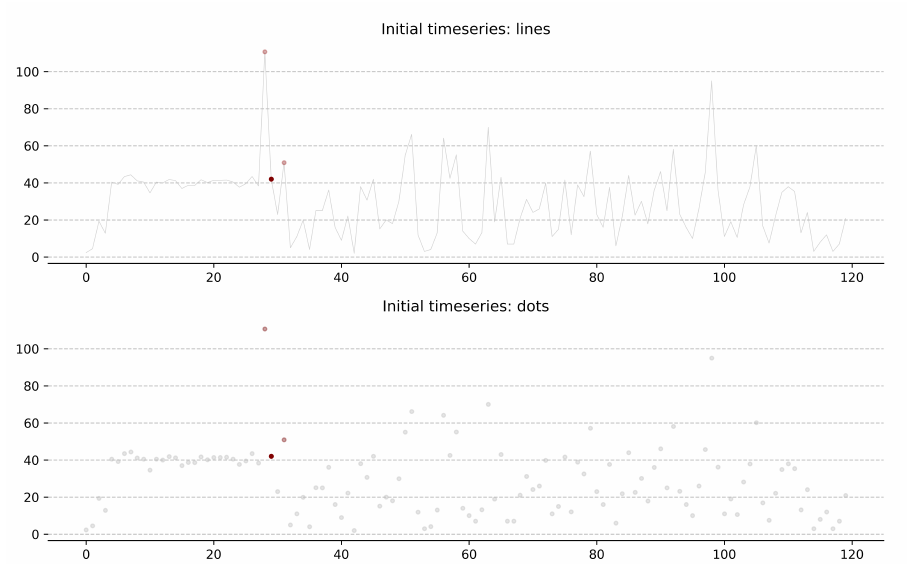
Figure 12. SIEM SPLUNK® Machine Learning Toolkit example time series without a seasonal component.